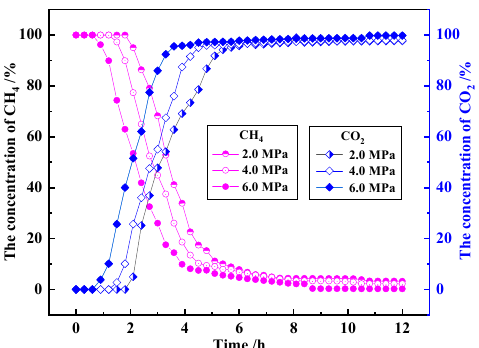
Figure 2. The CH 4 and CO 2 concentration changes under different pressures.